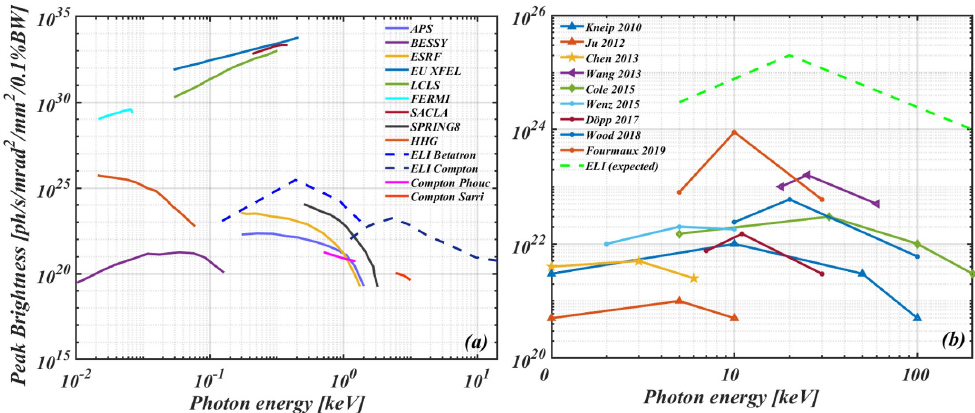
Figure 1. ( a ) Peak brightness for different X-ray sources: The APS synchrotron in the USA, the BESSY facility in Germany, ESRF in France, EU XFEL in Germany, the LCLS facility in the USA, FERMI in Italy, SACLA in Japan, the SPRING synchrotron facility in Japan, the HHG beamline at ELI Beamlines [10], the ELI Beamlines Gammatron beamline and all-optical Compton sources [19,29]. ( b ) Peak brightness of the laser plasma accelerator (LPA)-driven Betatron X-ray source at different laser facilities [30–38] and the expected brightness of the Betatron X-ray source at ELI